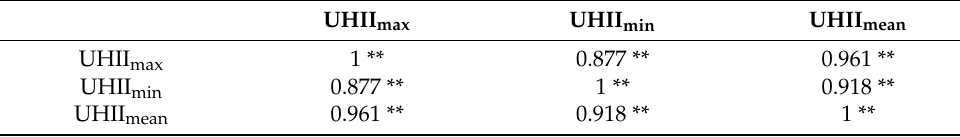
Table 5. Correlation matrix of UHII (UHII mean , UHII max , UHII min ).